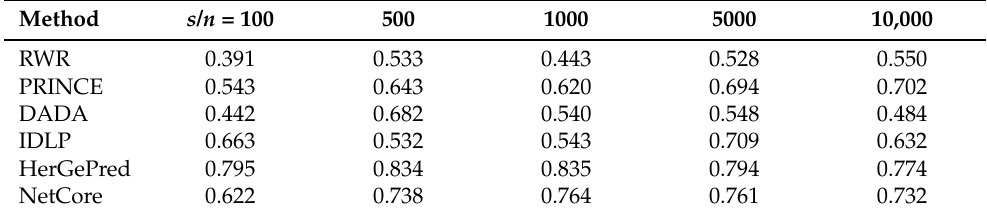
Table 5. AUC results evaluated by prediction scores for disease-gene association prediction with known disease genes from sample-1.